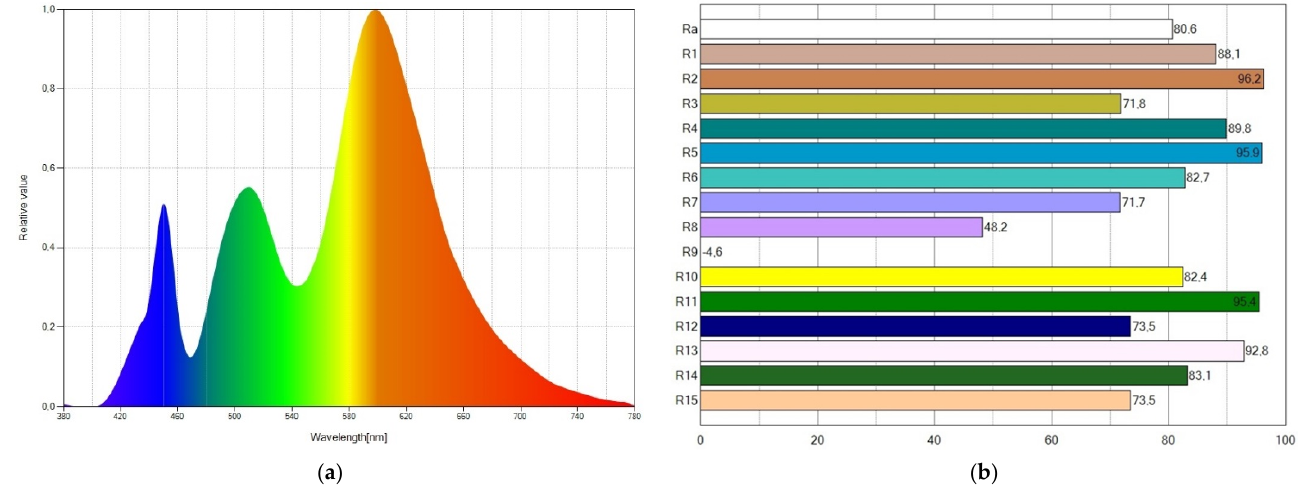
Figure 5. For WLED15, ( a ) spectral power distribution showing a short blue peak and ( b ) CRI values reaching a CRI (R a ) value of 80.6.